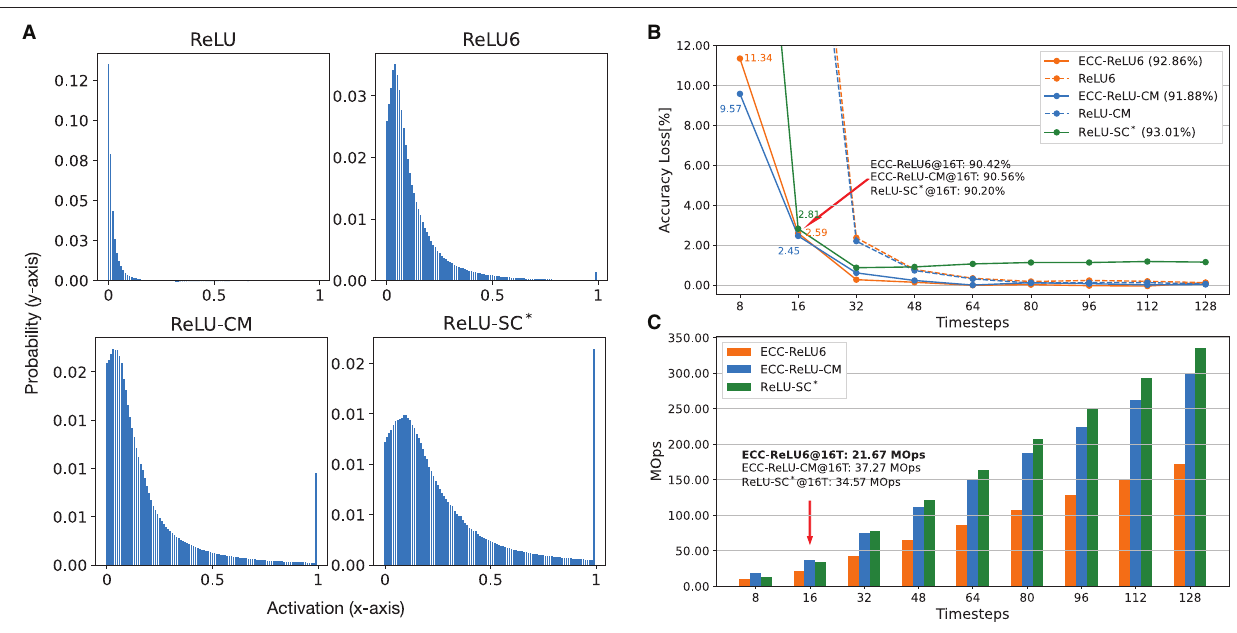
Frontiers in Neuroscience |